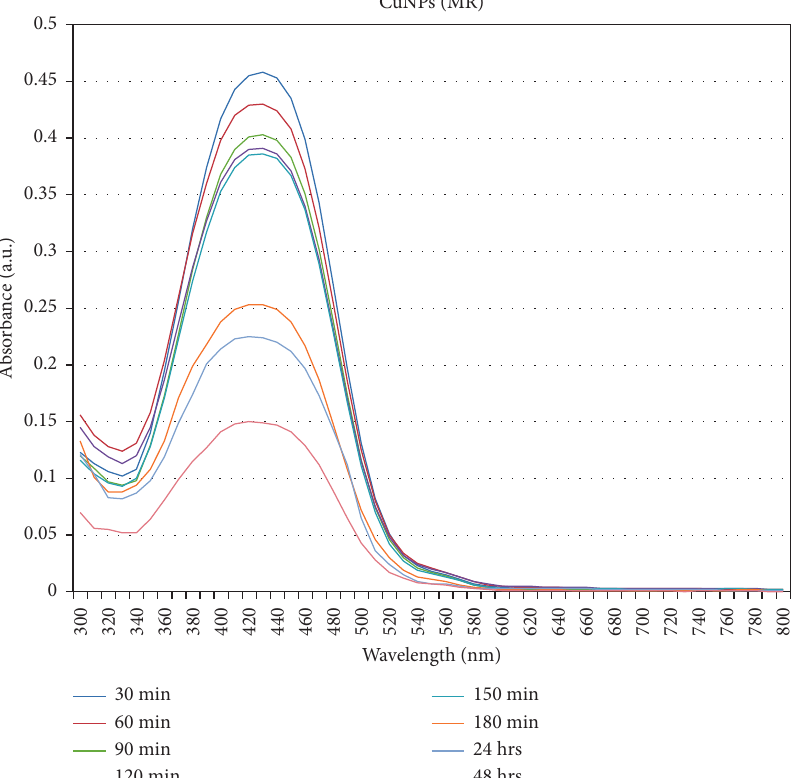
Figure 10: Catalytic degradation of methyl red using copper nanoparticles. Y -axis: absorbance, and X -axis: wavelength in nm. 00.511.522.5